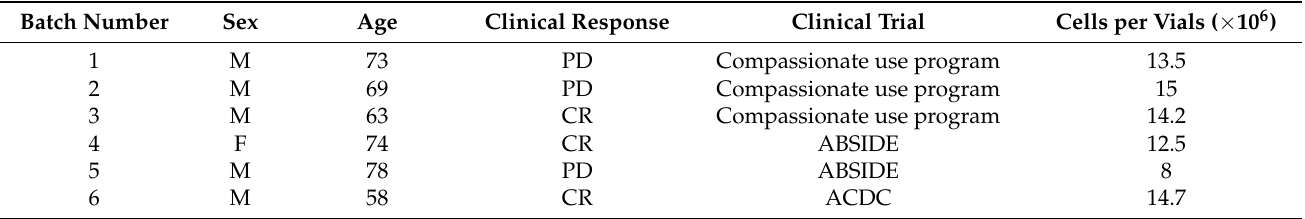
Table 1. Summary of patient and batch